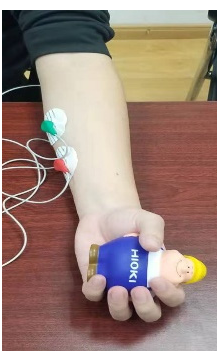
Figure 14. Muscle group location.